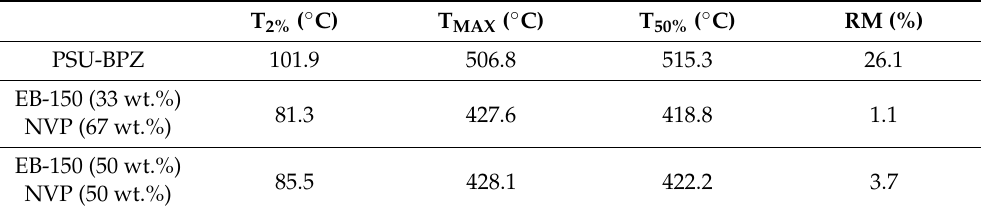
Figure 7. 1 HNMR spectra of the bisphenol Z polysulfone: ( a ) full spectrum range; ( b ) a fragment of the spectrum from 1.2 to 2.4 ppm (containing the signals of the cycloalcane rings); ( c ) a fragment of the spectrum from 6.9 to 7.9 ppm (containing signals from aromatic rings). Table 4. Numerical values of the thermogravimetry analysis of the bisphenol Z polysulfone and copolymers without